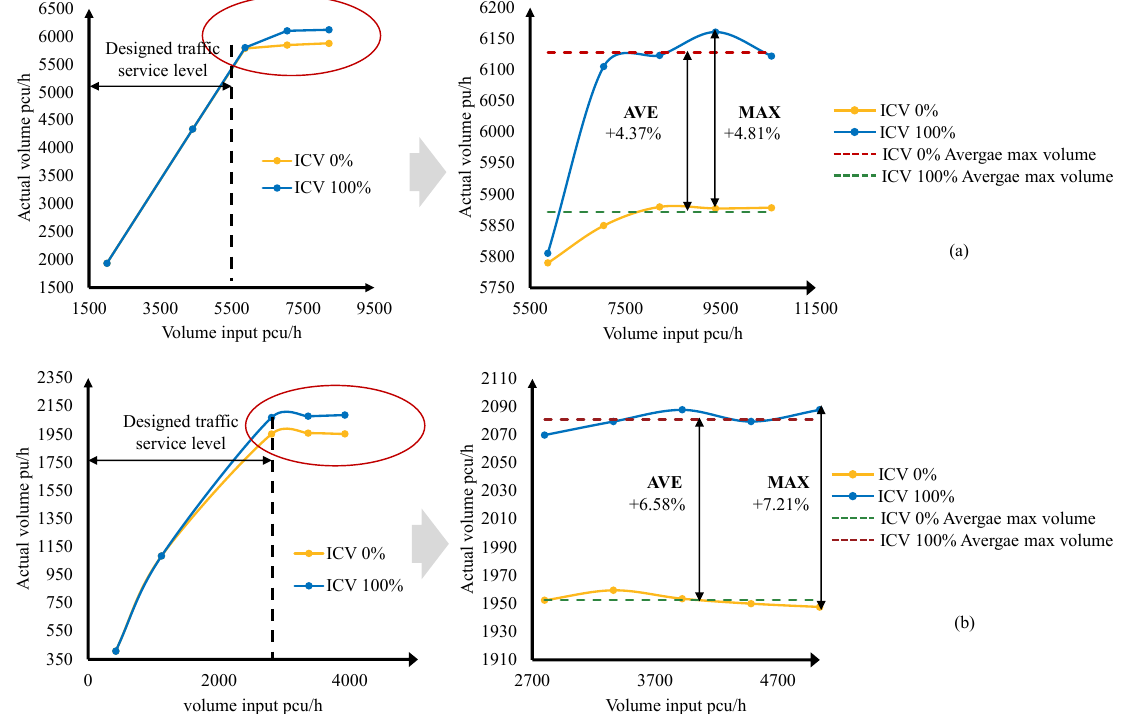
Figure 2. The impacts of SLADS on the road capacity on the expressway ( a ) and the secondary motorway ( b ).